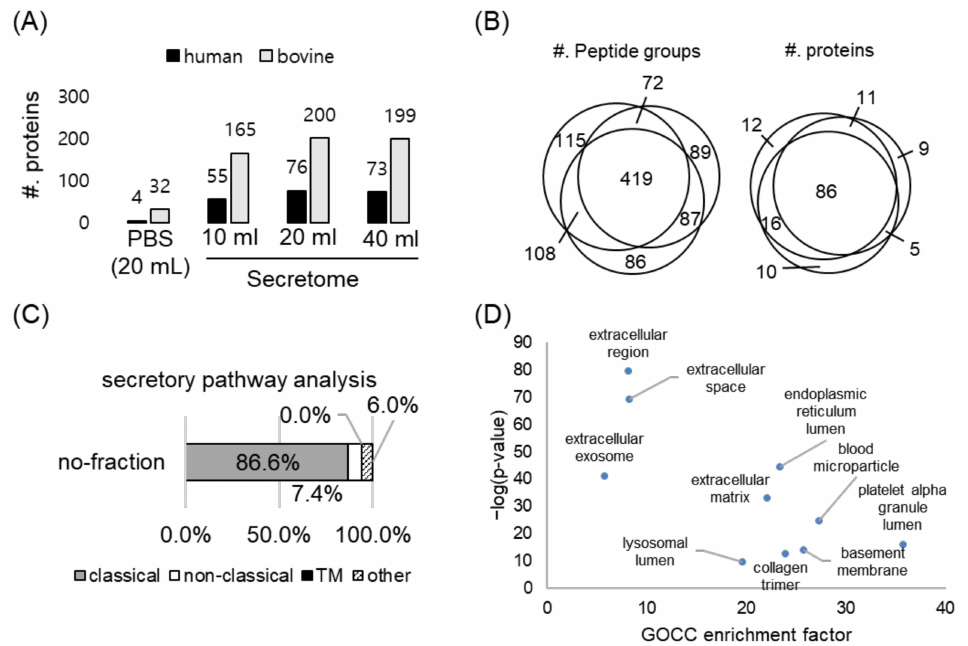
Figure 3. Enrichment of ANL-labeled proteins in the secretome. ( A ) Optimization of the ratio between the conditioned media volume and the alkyne-containing bead volume. In our strategy, 15 mL of the conditioned medium is the optimal point in terms of the depth of the secretome profile. ( B ) Reproducibility of our enrichment strategy: 79.2% (or 70.3%) of proteins (or peptides) were identified in at least two out of three replicates. ( C ) The secretory pathway analysis of the identified proteins in secretome after enrichment using SignalP, SecretomeP, and TMHMM. ( D ) Gene ontology cellular component analysis of the identified proteins in secretome after